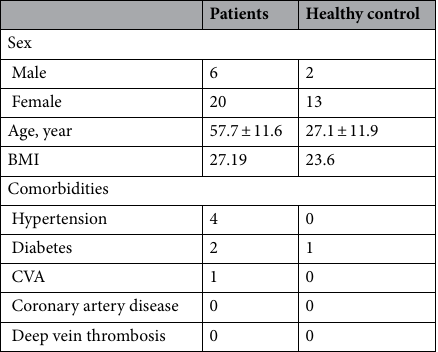
Table 1. Clinical characteristics of patients with venous reflux and the healthy